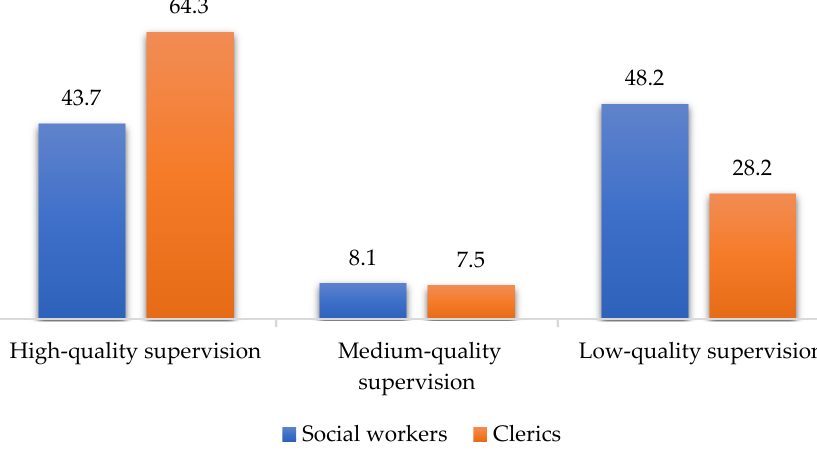
Figure 3. SQAS scores for social workers and clerics.